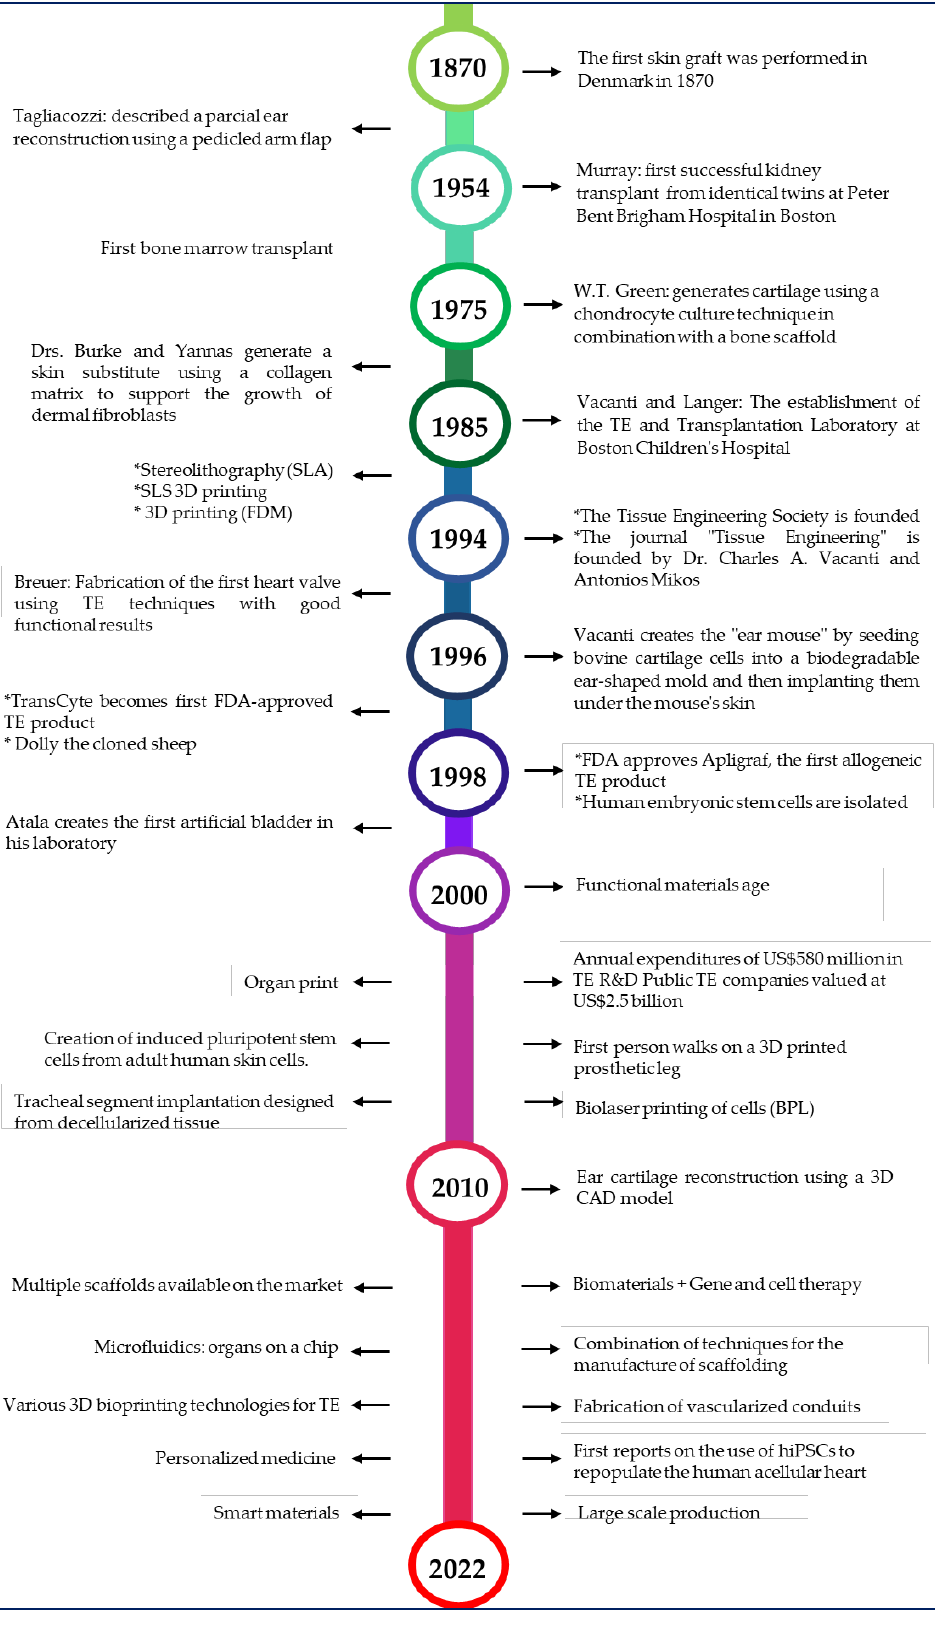
Figure 1. Timeline of tissue engineering [6–8,18–26].